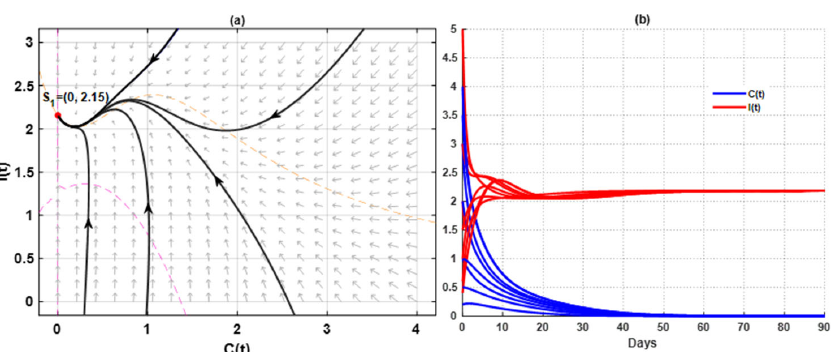
Figure 5. Numerical simulations of the CICV model for the data given in Table 1. ( a ) Phase portrait of the CICV model. ( b ) Time series of the CICV model.